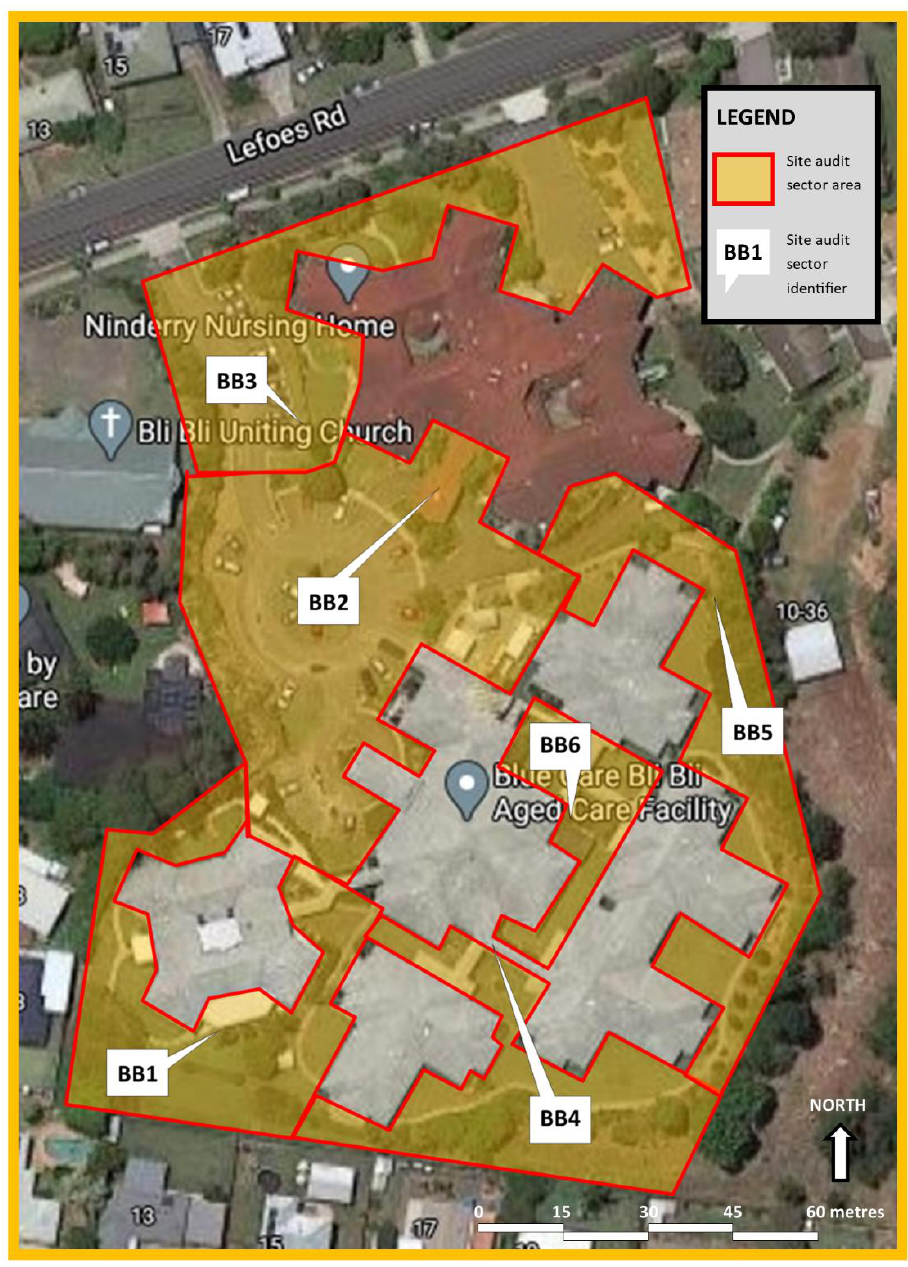
Figure 3. Bli Bli Aged Care Facility site image with audit sector assignment (Image Source: Google Maps).